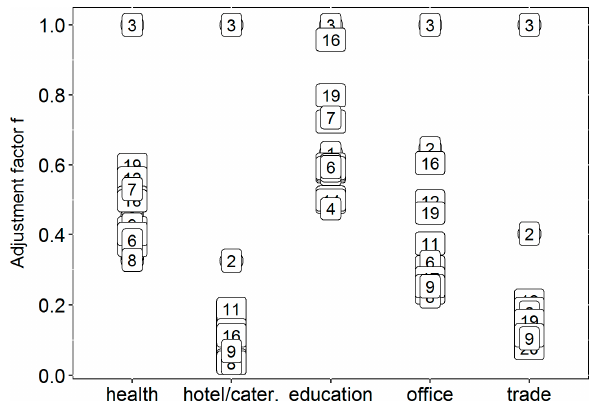
Figure 6. Adjustment factor f for each county and non ‐ residential building category.